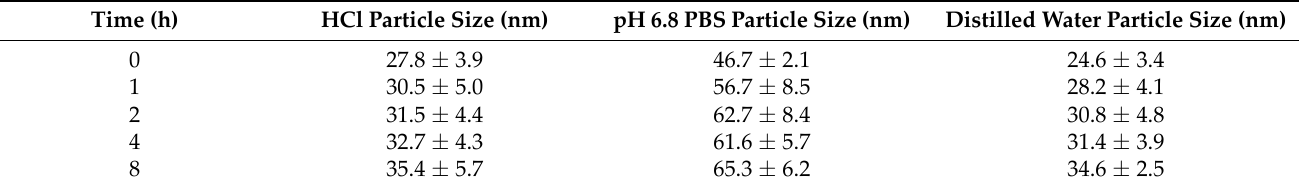
Table 10. Stability of particle size after self-microemulsifying in 0.1M HCl, pH6.8 PBS, and distilled water at 37 °C.